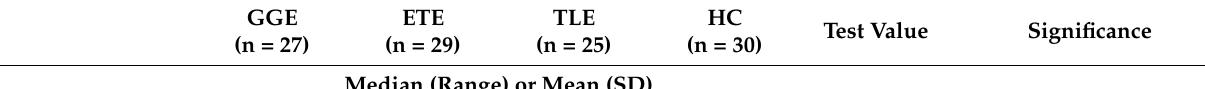
Table 2. The comparison of social cognitive tests and quality of life between groups of people with epilepsy and healthy